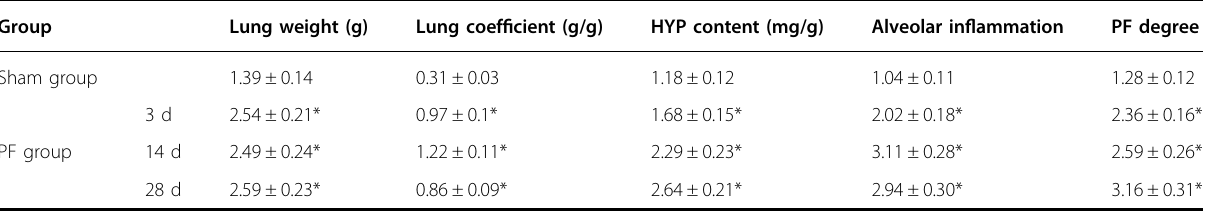
Table 3 PF-related parameters in rats after modeling Group